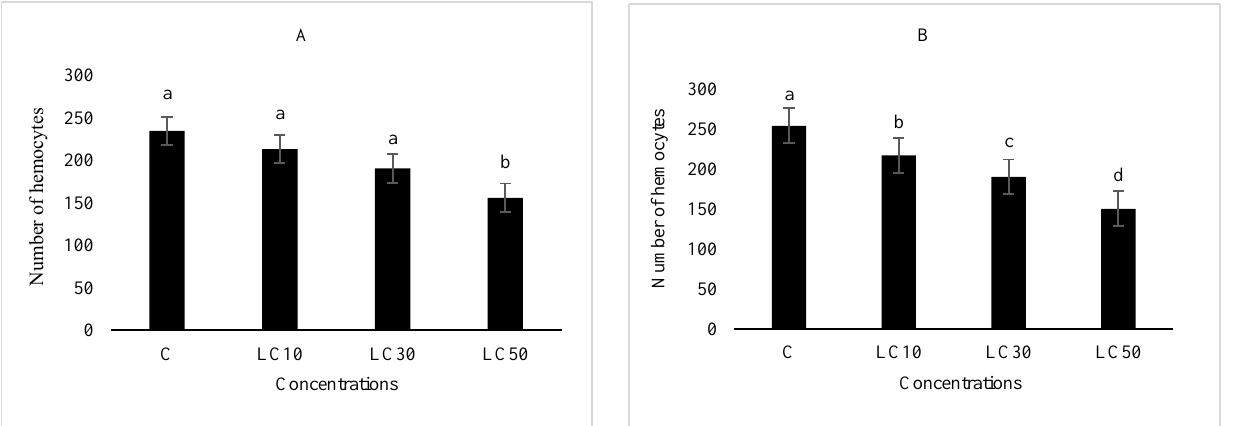
Figure 1. The effect of Artemisia annua floral essential oil on total hemocyte counts (THC) of Glyphodes pyloalis larvae treated with oral ( A ) and fumigant ( B ) assays. Bars with different letters above them indicate significant differences between means at p < 0.05, Tukey’s test. Number of hemocytes × 10 4 .